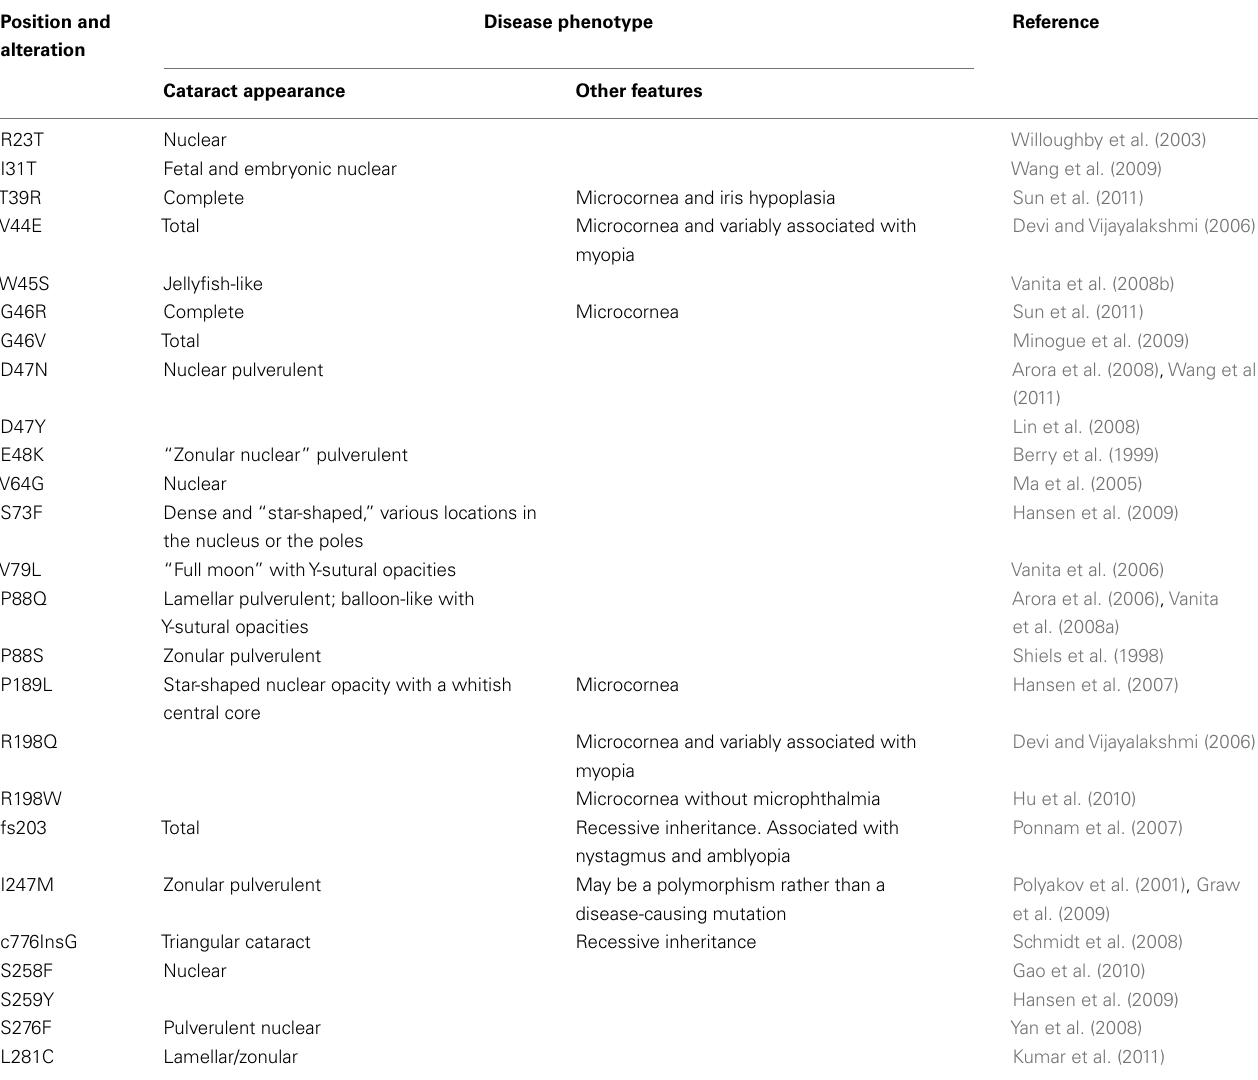
Table 2 | Human Cx50 mutants linked to cataract